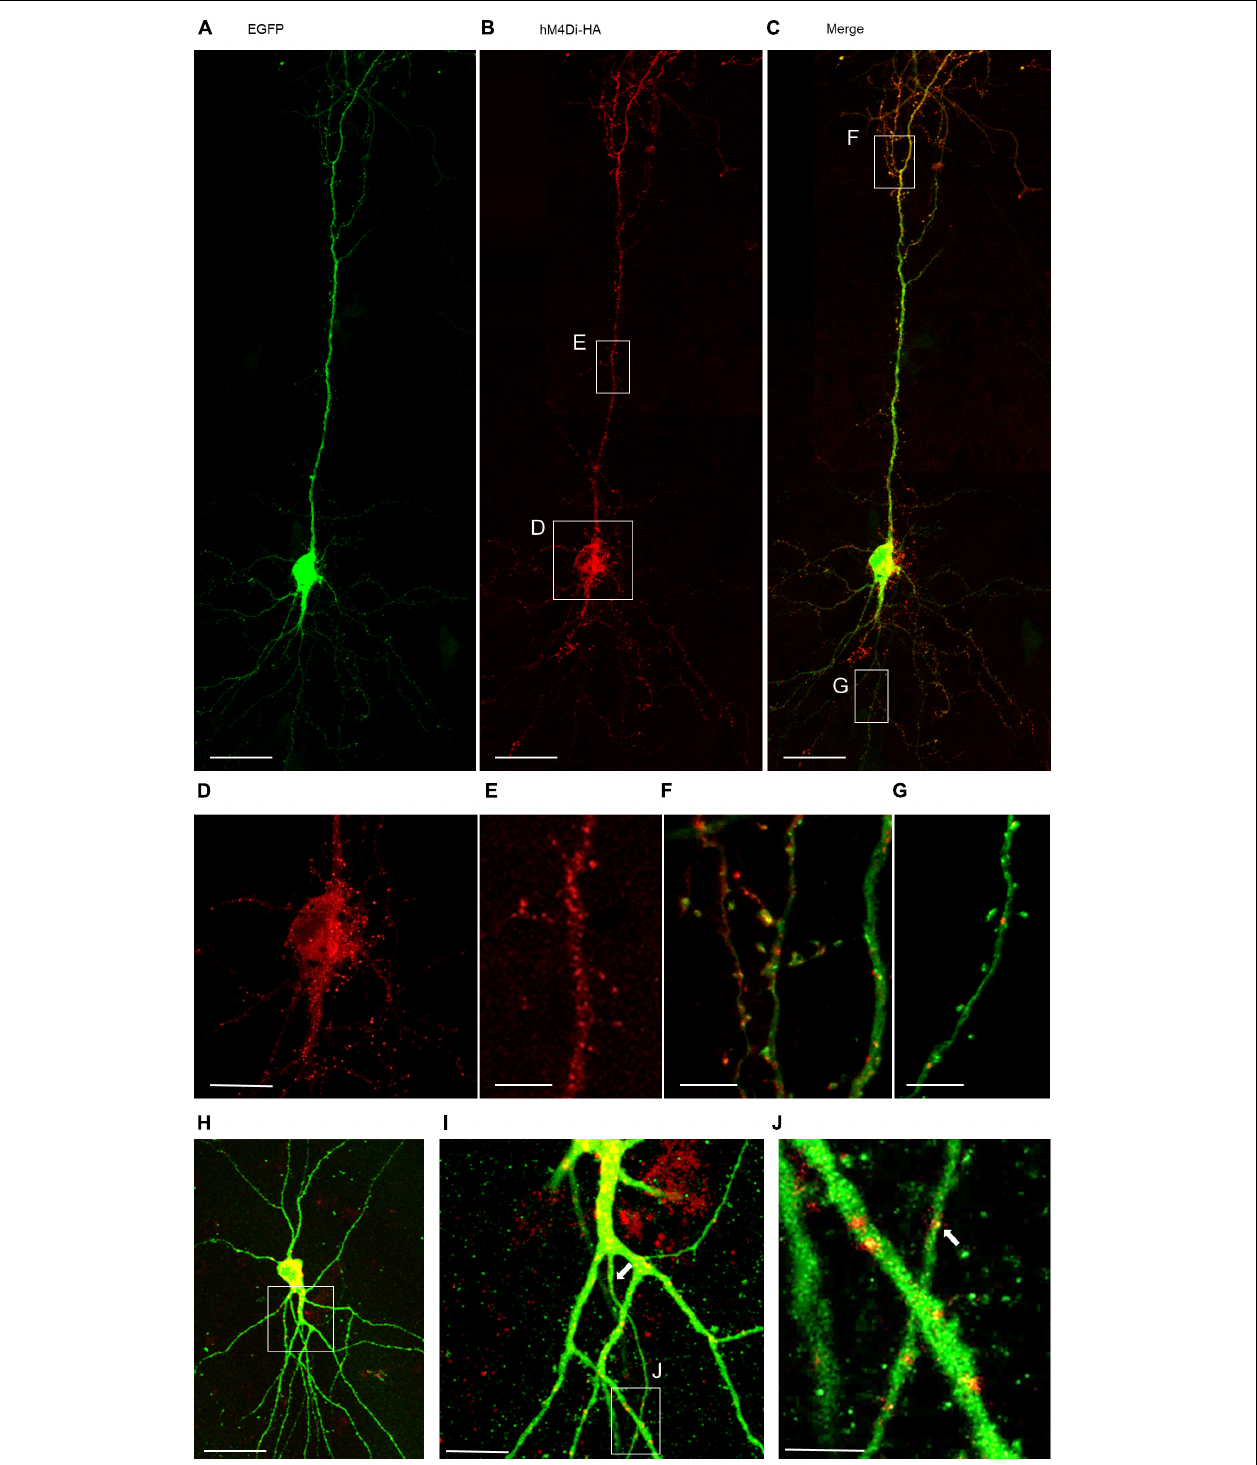
FIGURE 1 | Immunofluorescent staining of a pyramidal neuron expressing HA-tagged hM4Di. Co-transfection of plasmids encoding EGFP (A) and HA-tagged hM4Di visualized with mouse anti-HA/Alexa-568 (B) , and merged (C,H) . The hM4Di receptor was expressed heterogeneously throughout the cell; with a high density in the soma (D) , the trunk of the apical dendrite (E,I) and in the apical tuft (F) . HM4Di clusters are located at the dendritic membrane sometimes associated with spines (F) . Isolated clusters of hM4Di were present in basal dendrites (G) and in the axon (J) . Pial surface is to the top. White arrows indicate the axon. Scale: 100 µ m for panels (A–C,H) ; 35 µ m (D,I) ; 25 µ m (E–G) ; 10 µ m (J) .